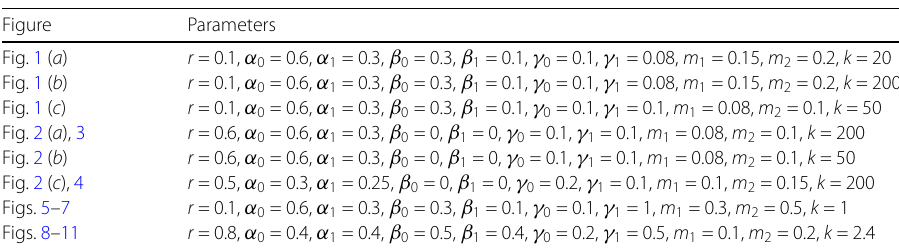
Time series plots for Experiment 1 with different parameters, for parameters see Table 2 Figs. 3–4 Phase diagram of Experiment 1 with different parameters, for parameters see Table 2 Figs. 5–7 Numerical solution and pattern of Experiment 2 with different initial conditions, for initial conditions see Table 3 Figs. 8–11 Numerical solution and pattern of Experiment 3 with different initial conditions, for initial conditions see Table 3